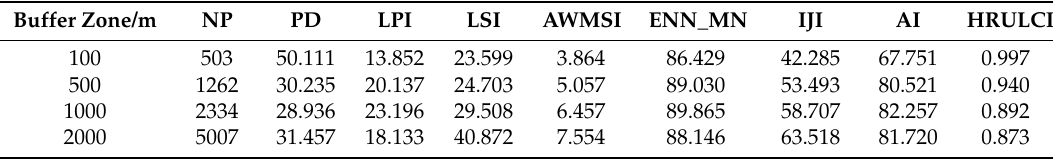
Table 3. Calculation results of landscape pattern index in different buffer zones.